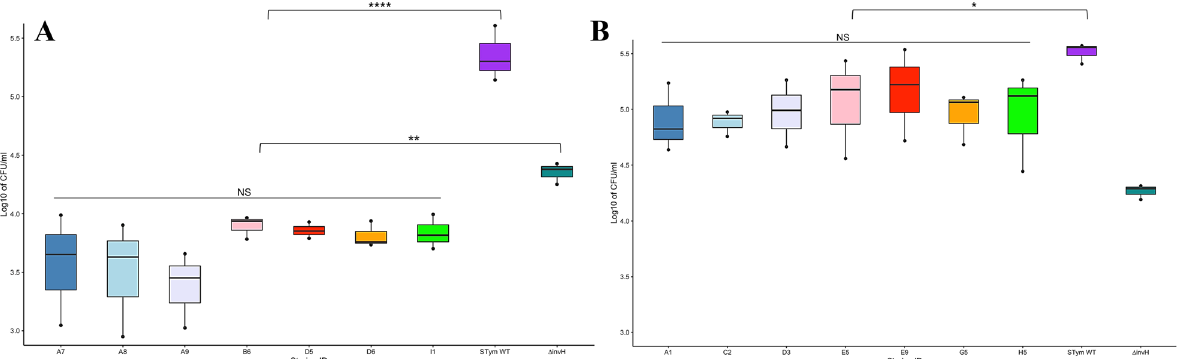
Figure 6. Invasion of S. Salamae ( A ) and S . Waycross ( B ) in human intestinal epithelial cell line INT-407. Each box plot represents one strain with values from three biological replicates and two technical replicates at each